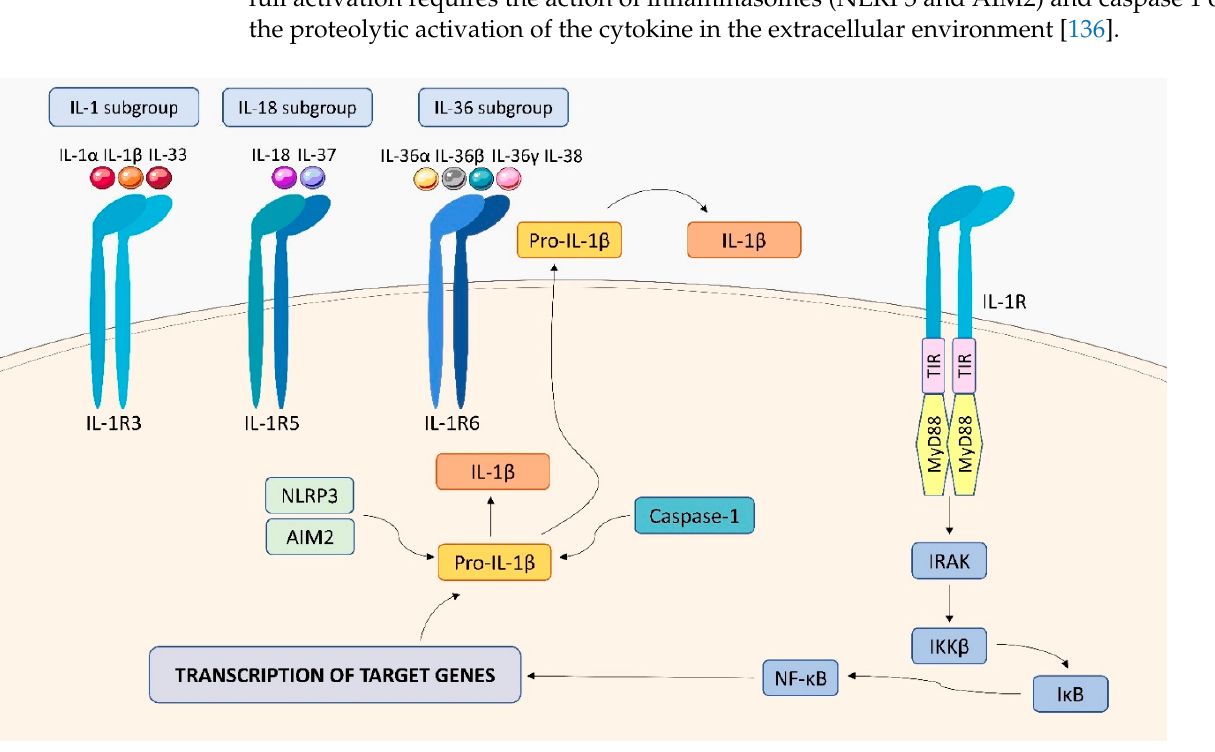
Figure 12. IL-1 family receptors structure and signaling. Receptors of the IL-1 family include IL-1R3, IL-1R5, and IL-1R6. Attachment of the appropriate cytokine to a specific receptor pair triggers a cascade of reactions, resulting in the activation of the transcription factor NF- κ B, which stimulates gene transcription in the cell nucleus, leading to the production of cytokines. IL-1 β is produced as an inactive precursor, and its activation requires the action of: NLRP3 and AIM2 and caspase 1.